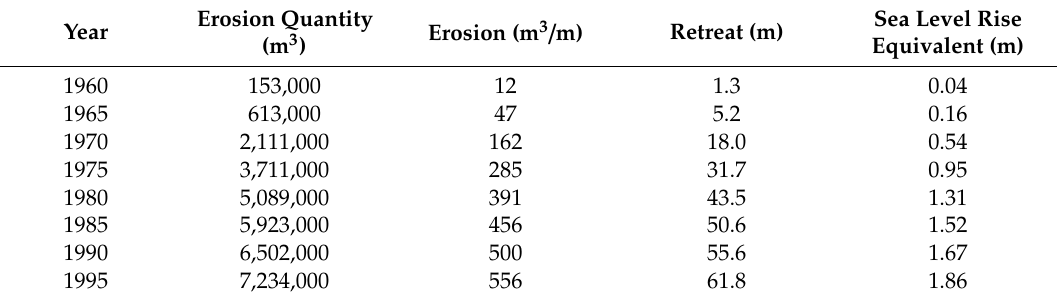
Table 4. Implied shoreline retreat and implied sea level rise (closure depth (h) = 12 m; height of dune (B) = 3 m; length of beach between Snapper Rocks and Burleigh Head = 13,000 m; horizontal distance from shoreline to o ff shore position of closure (L) = 500 m).